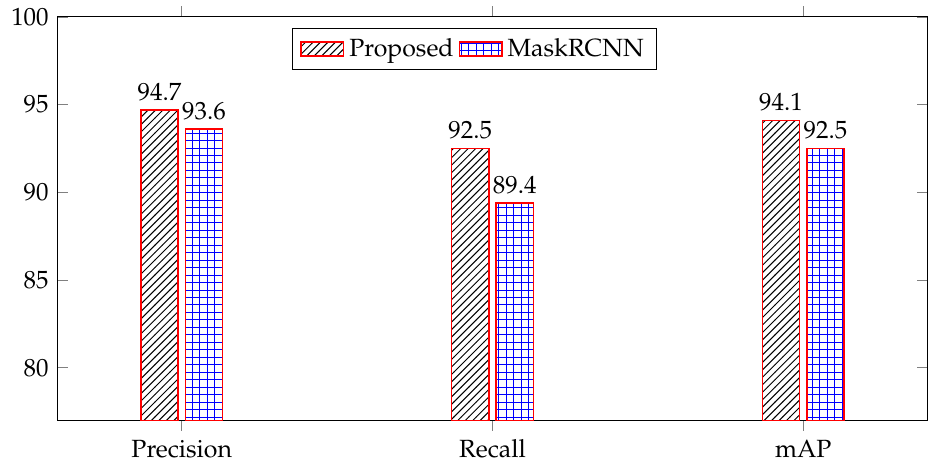
Figure 13. Precision, recall, and mAP results for the testing set using the proposed model compared to Behera and Bazil [42] and Tan et al. [43].